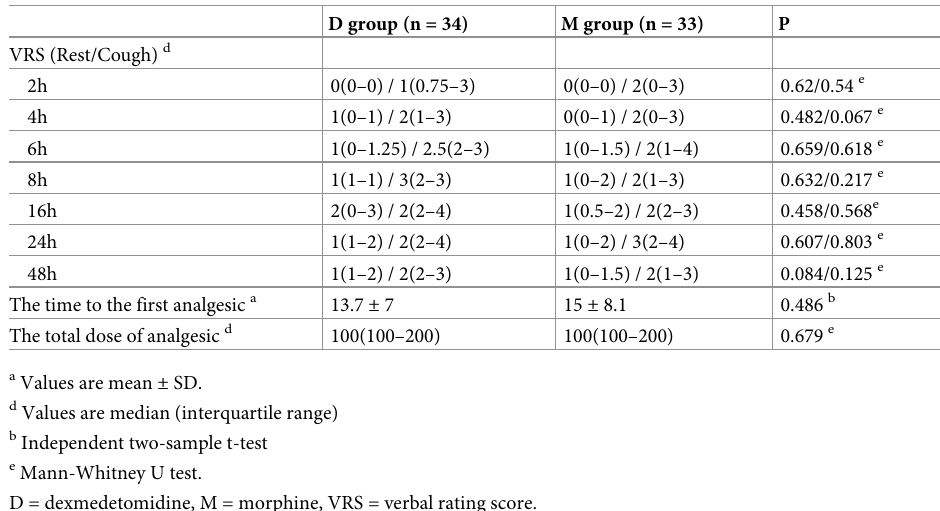
Table 2. Post-operative pain rating during 48 h, the time to the first analgesic and total dose of analgesic in both the groups. D group (n = 34) M group (n = 33) VRS (Rest/Cough) d 2h